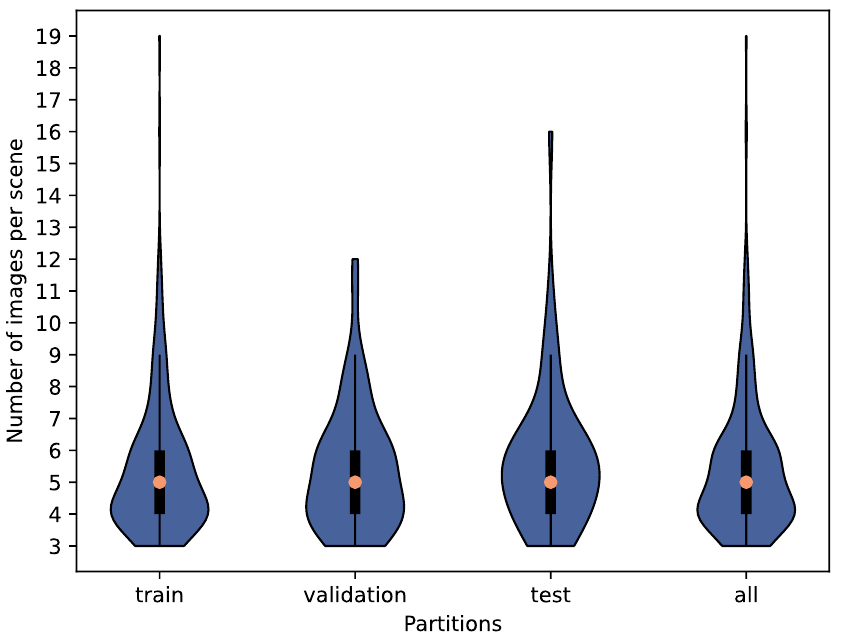
Figure 10. Distribution of images per viewpoint angle (scene) for each partition for images with human demonstration.